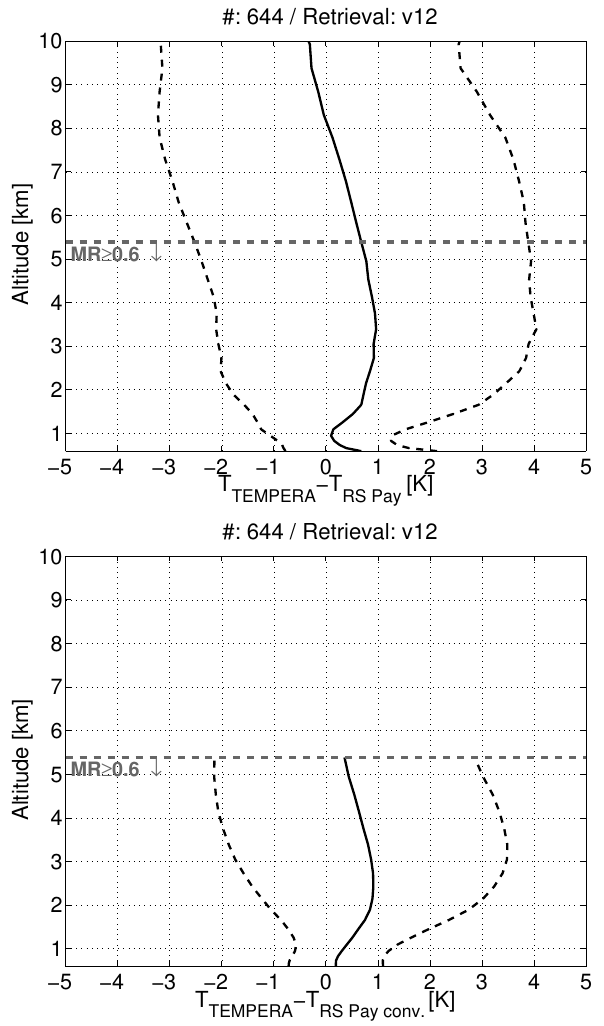
Fig. 12. Comparison of 644 profiles (1 January to 13 Decem- ber 2012) between TEMPERA and radiosonde data from Payerne over an altitude range from ground (0.575km) to 10km. Plotted are the mean (black line) and plus and minus one standard devia- tion around the mean (black dashed line) of the differences between TEMPERA and radiosonde data from Payerne. The horizontal dark grey line indicates the region where MR=0.6. Upper panel: TEM- PERA compared with unconvolved radiosonde data from Payerne. Lower panel: TEMPERA compared with convolved radiosonde data from Payerne over an altitude region with MR ≥ 0.6.